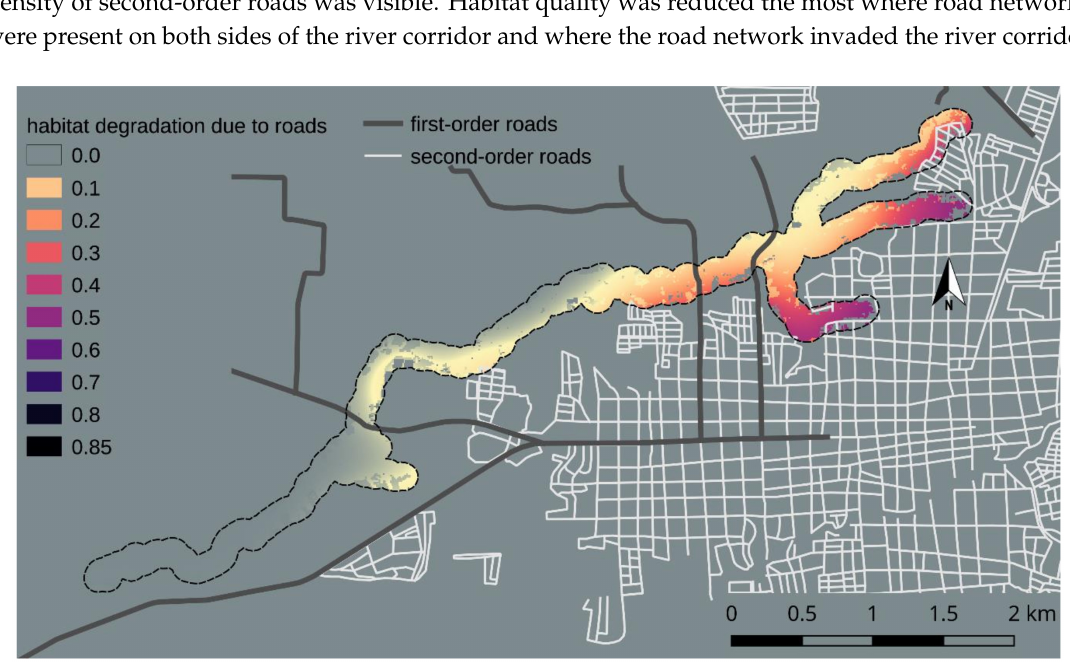
Figure 4. Threat impact of first- and second-order roads on habitat quality in the study area. The grey shade is used as a background to provide a better